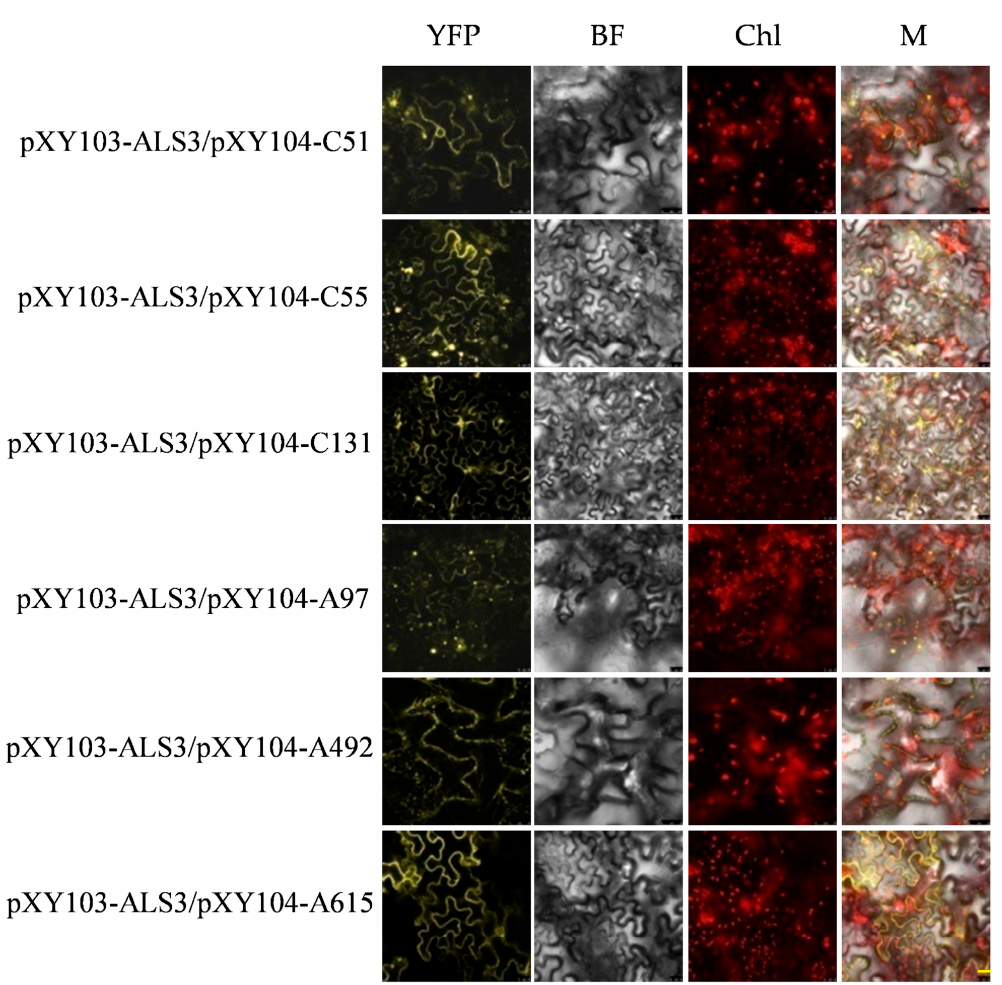
Figure 6. Fluorescence signal of ALS3 and its interacting proteins in tobacco mesophyll epidermal cells. YFP: yellow fluorescent protein; BF: bright field; Chl: autofluorescence of chloroplasts; M: merging of YFP, BF and Chl images. The value of scale bar with yellow color on the lower right of the figure is 25 μ m.